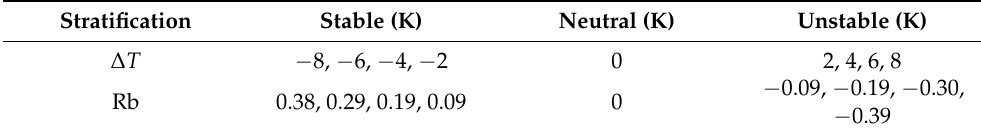
Table 3. Stratification parameters. The temperature at the inflow boundary, T inlet , is fixed at 300 K. Stratification Stable (K) Neutral (K) Unstable (K) ∆